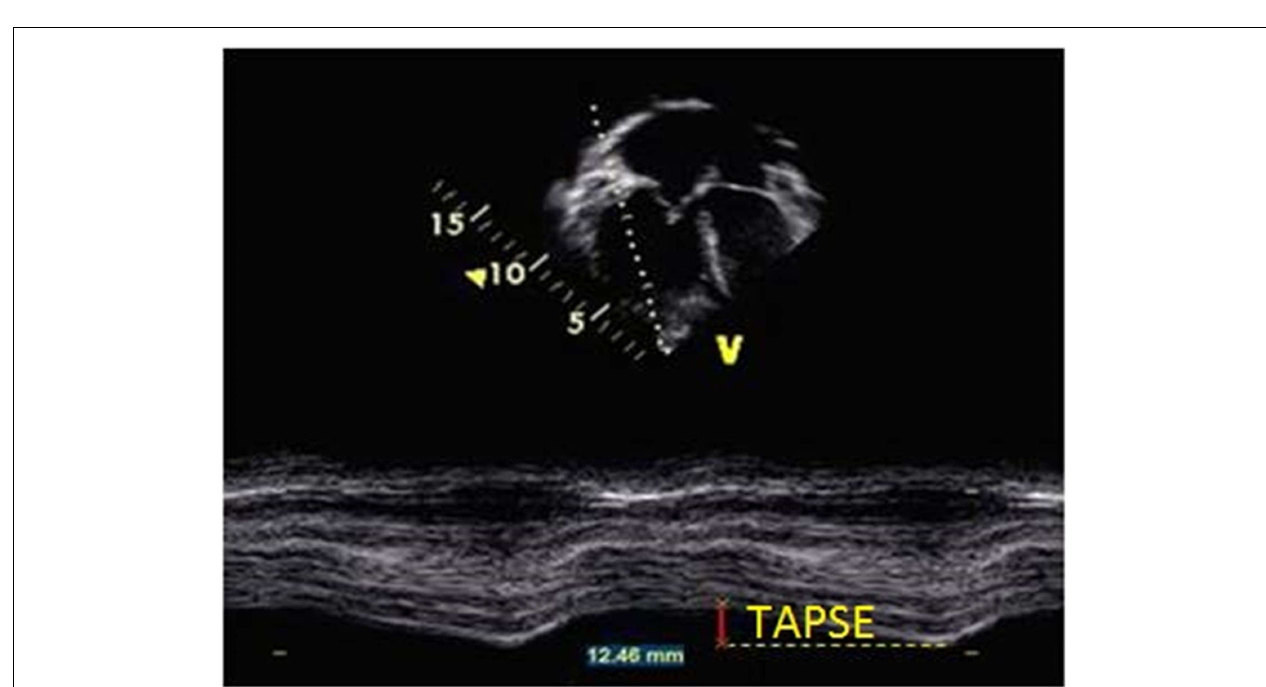
FIGURE 11 | Measurement of tricuspid annular plane systolic excursion (TAPSE) from M-mode in the apical four-chamber view at the level of the tricuspid annulus in a patient with pulmonary hypertension